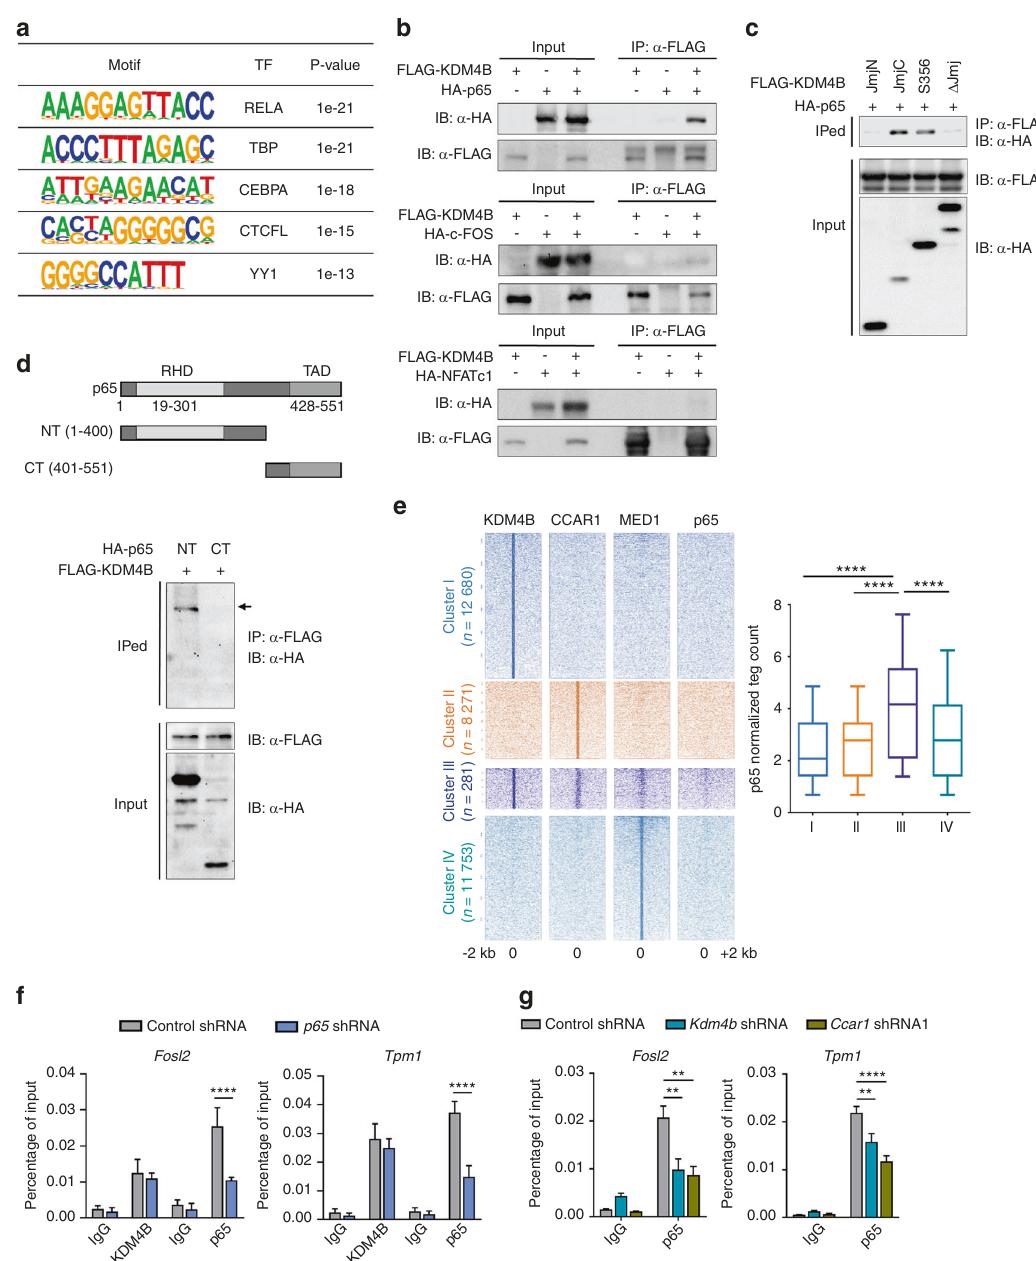
Fig. 6 Association of p65 and KDM4B is critical for osteoclastogenesis. a The most signi fi cantly enriched transcription factor (TF) motifs at KDM4B binding regions, as identi fi ed by de novo motif analysis using HOMER. b KDM4B interaction with p65. c , d Mapping the binding domain of KDM4B and p65. RHD Rel homology domain, TAD transactivation domain. e Heatmap of normalized tag densities on KDM4B, CCAR1, MED1, and p65 peaks (left panels). Quanti fi cations of p65 tag counts are shown in the box plots (right panel). The boxes enclose the 25th to 75th percentile values. The whiskers extend to the 10th and 90th percentiles. The central horizontal bar indicates the median. **** P < 0.000 1 (Kolmogorov – Smirnov test). f ChIP assay of KDM4B occupancy at the Fosl2 or Tpm1 promoter in p65-depleted cells. g ChIP assay of p65 occupancy at the Fosl2 or Tpm1 promoter in KDM4B- or CCAR1-depleted cells. The data are presented as the mean ± SD values of three independent experiments [two-way ANOVA in ( f , g )]. ** P < 0.01; *** P < 0.001. See also Supplementary Fig. was also required for KDM4B-mediated H3K9 demethylase activity Using a series of column chromatographic puri fi cation and mass and functioned as a bridge between KDM4B and the Mediator spectrometric analyses, we puri fi ed several interacting partners complex. It is still unclear how CCAR1 regulates the demethylase associated with KDM4B and characterized CCAR1 as a factor activity of KDM4B. We observed that CCAR1 had no effect on required for KDM4B-mediated osteoclastogenesis. CCAR1 physi- KDM4B occupancy at the promoter regions of target genes cally interacted with KDM4B, and the pattern of CCAR1 expression (Fig. 5b). Given that histone-modifying enzymes often work in was very similar to that of KDM4B. Knockdown of CCAR1 inhibited concert with other modi fi ers, transcription factors, and the RANKL-induced osteoclastogenesis, and KDM4B – CCAR1 coloca- transcriptional machinery, one possible explanation is that CCAR1 lized to the promoter regions of osteoclast-related genes. CCAR1